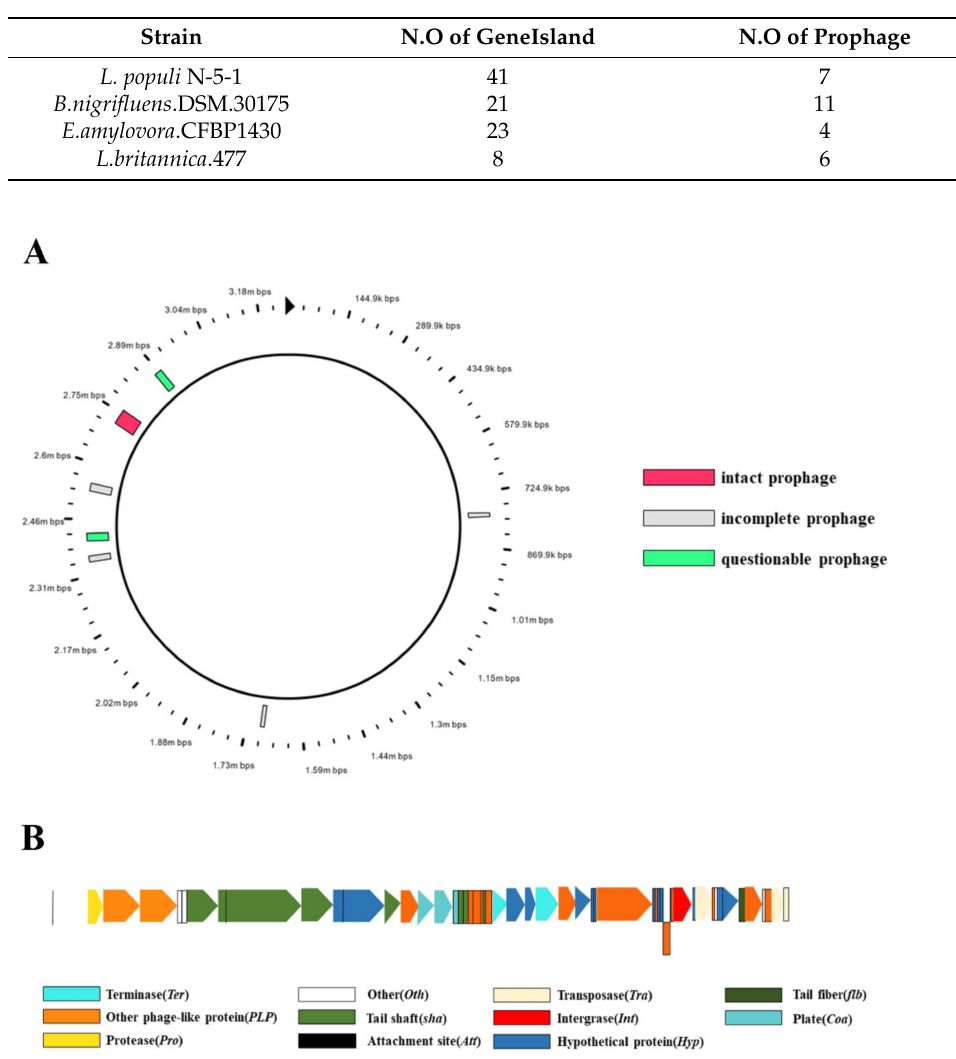
Figure 5. Prophage distribution and structure. ( A ) Prophage distribution in the N-5-1 genome. The red box represents complete prephages; the gray box represents incomplete prephages; the green box represents suspected prephages. ( B ) Prophage-6 structure. Different colored blocks represent genes encoding different functions. Prophage-6 contains 59 coding